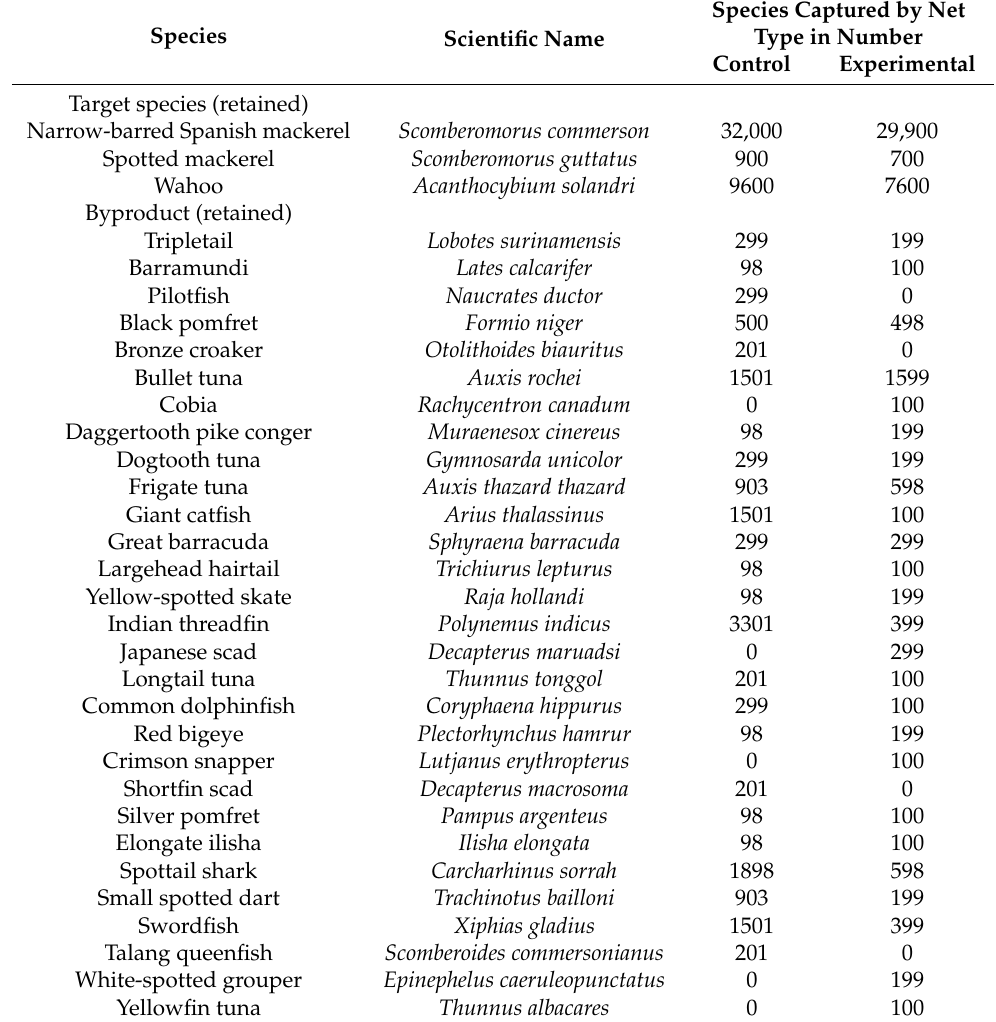
Table 1. Summary of all species captured during the fishing experiment for control and experimental